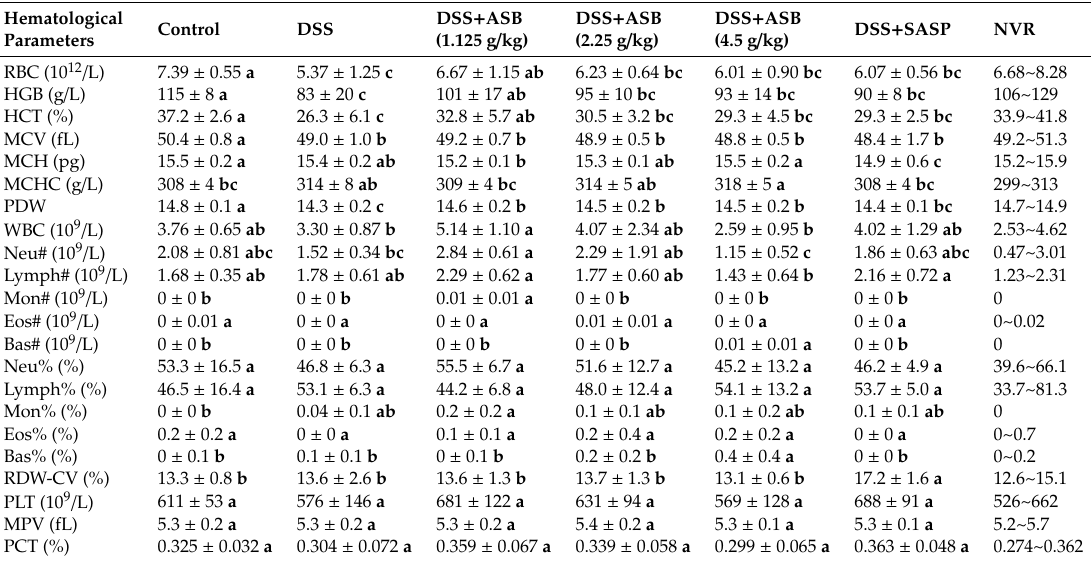
Table 1. Hematological parameters in